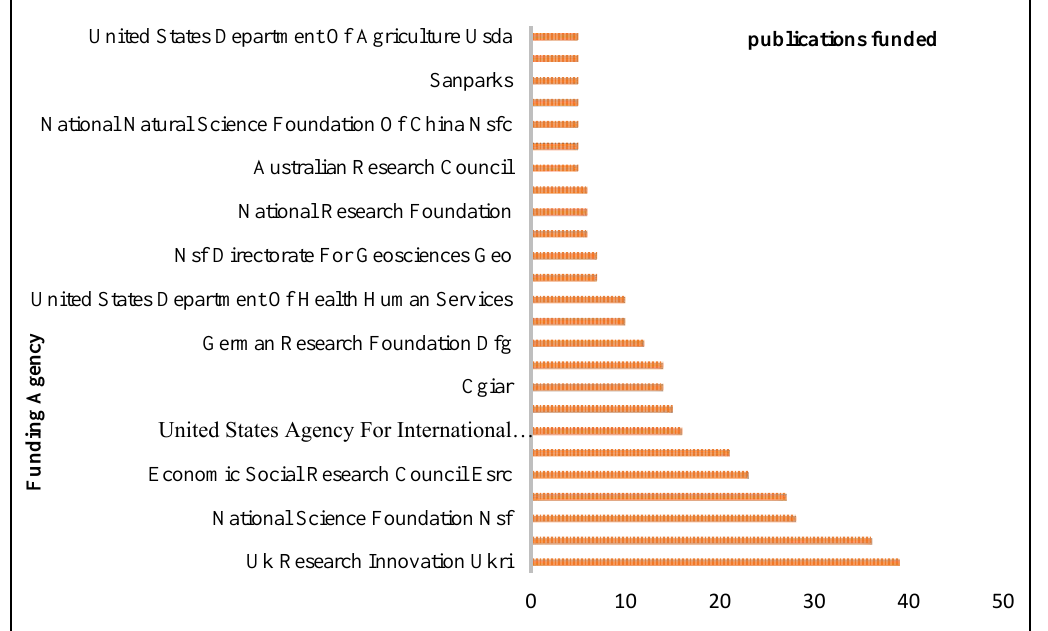
Figure 7. Funding agencies and their funded publications in southern African ES research from 2010 to 2021 .